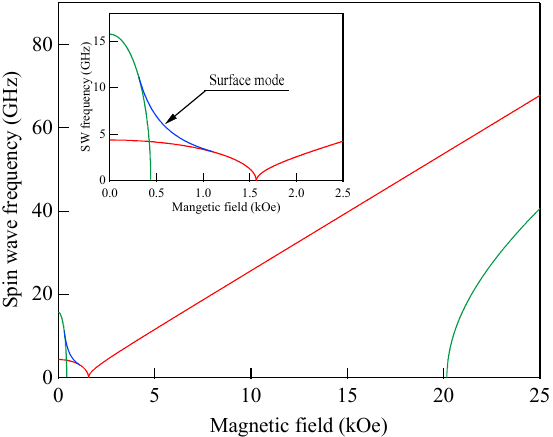
Figure 22. A simulation of the SW frequencies for an out‑of‑plane magnetized ferromagnetic slab as a function of the magnetic field. Here, the red lines and the green lines show the upper and lower bound of the bulk SW band. We used the magnetic constants obtained from the Fe wedge given in the text. The inset shows the lower field result below 2.5 kOe. Note the boundary crossing below H ∼ 0.4 kOe.